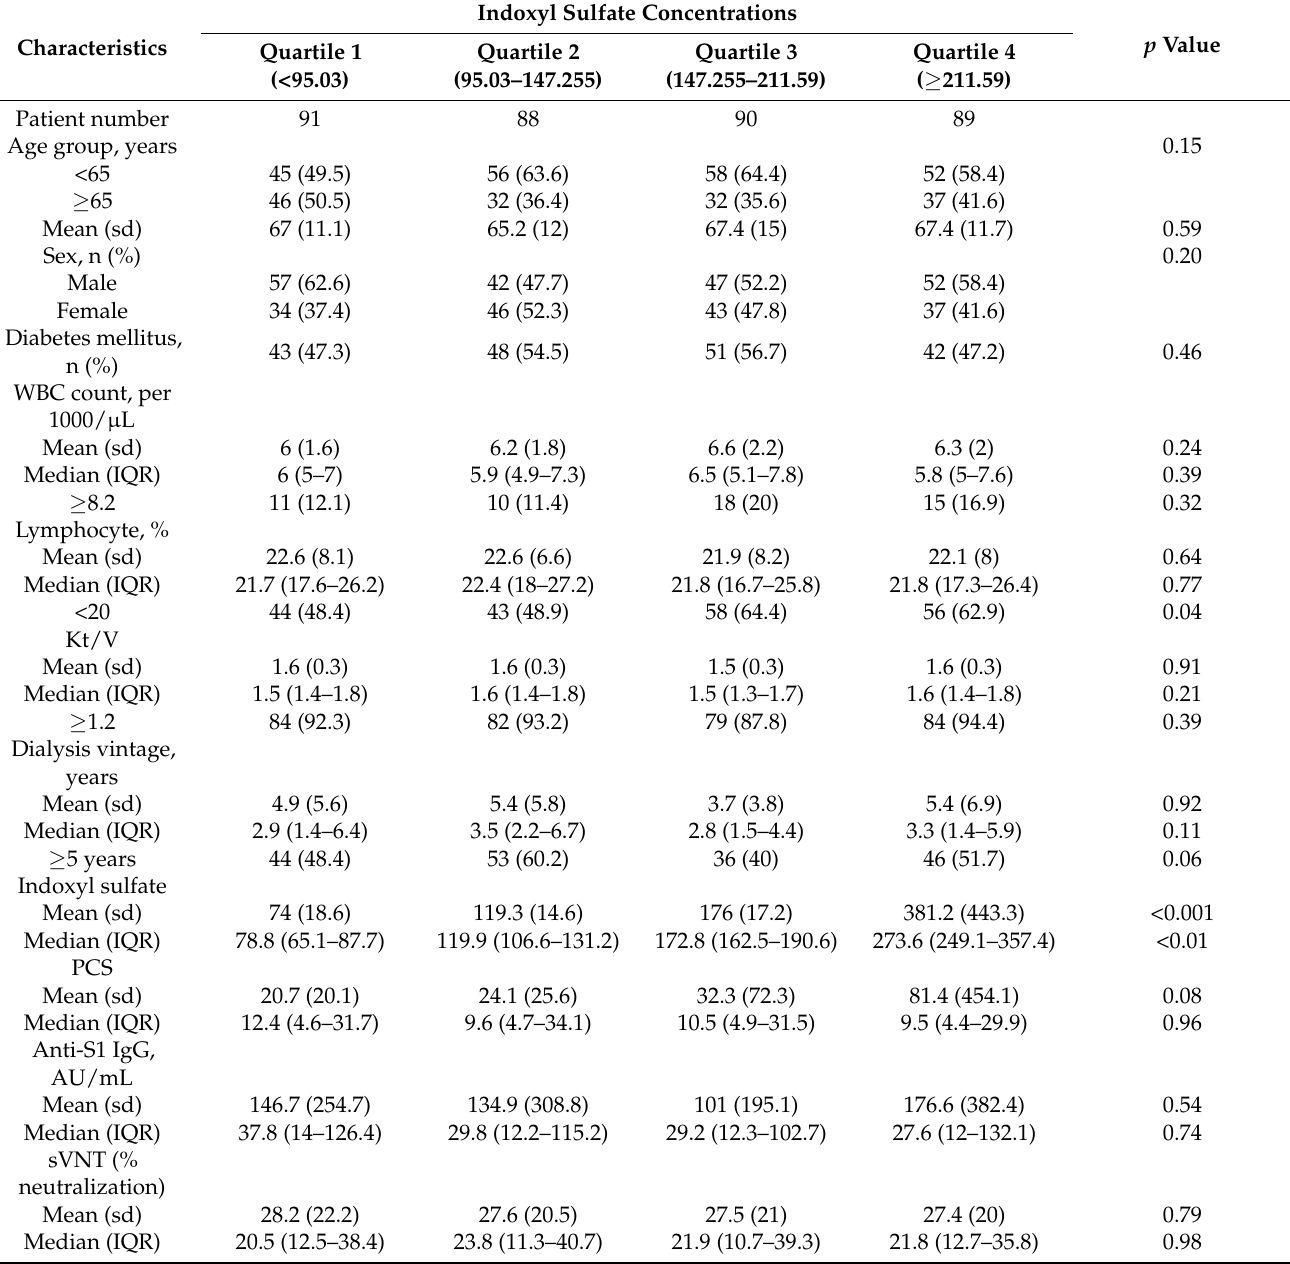
Table 1. Demographics of the hemodialysis patients grouped based on the concentration of indoxyl